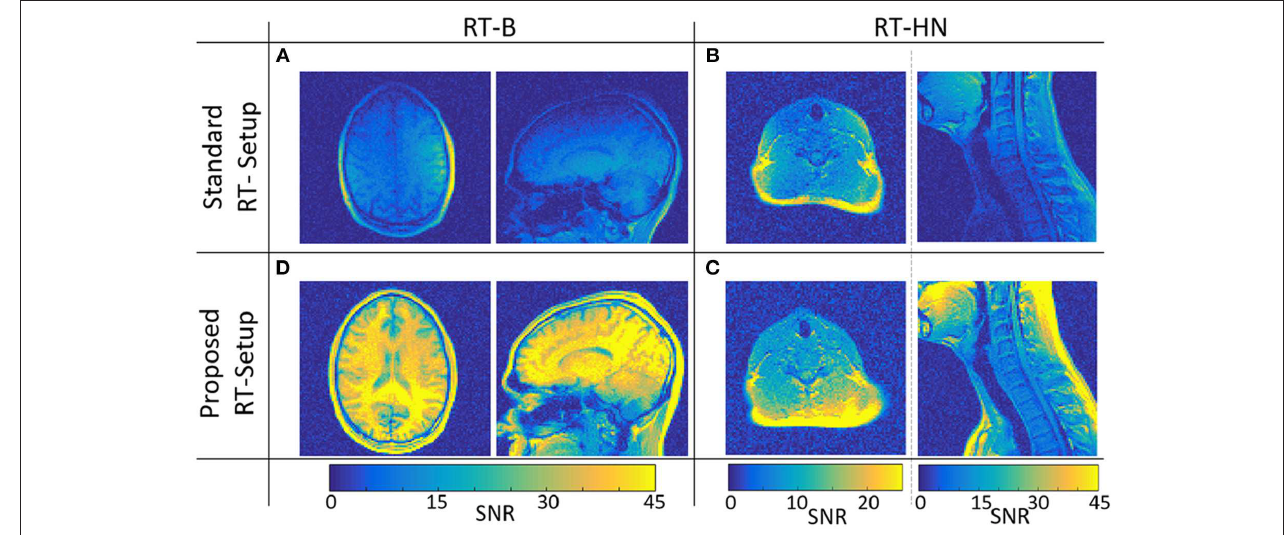
FIGURE 2 | SNR maps for the standard (A,B) and the proposed (C,D) RT-B and RT-HN setups,